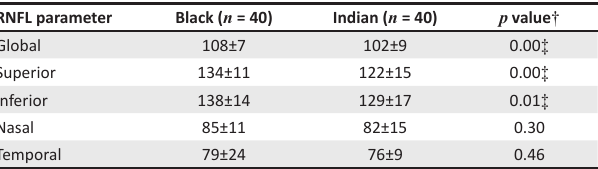
TABLE 3: Means and standard deviations for retinal nerve fibre layer thickness variations in male and female participants.